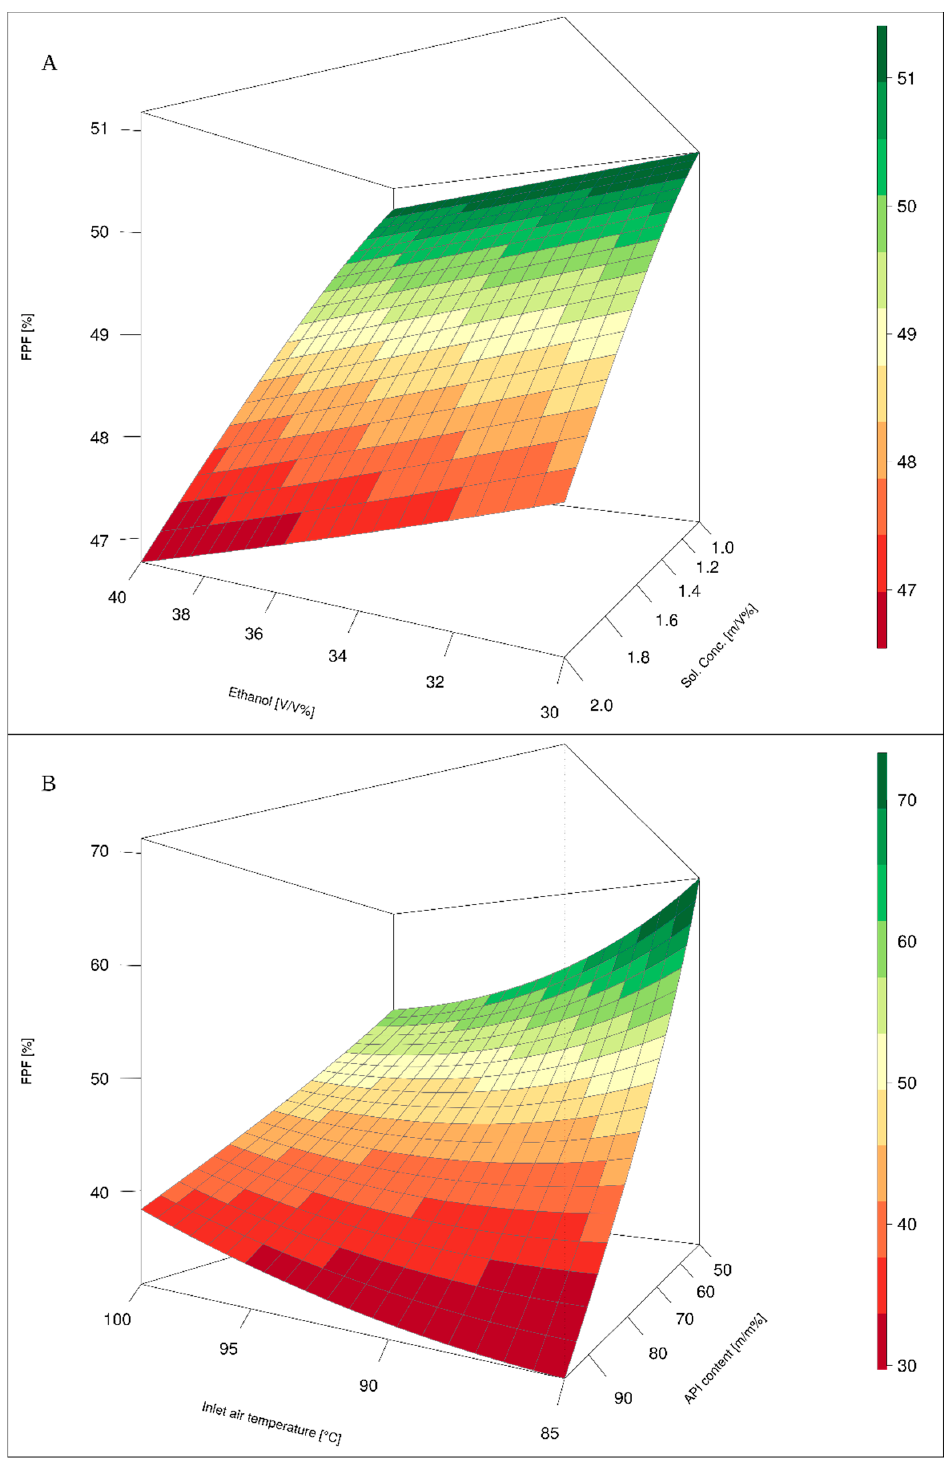
Figure 6. Factors influencing predicted FPF value: ( A ) ethanol to water ratio (Ethanol) and feed solution concentration (Sol. Conc.); ( B ) API to excipient ratio (API content) and inlet air temperature. FPF—fine particle fraction.